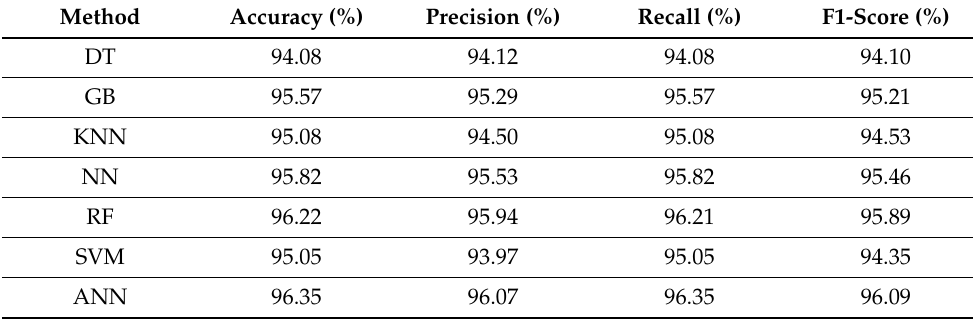
Table 10. Result of machine learning using random split dataset.